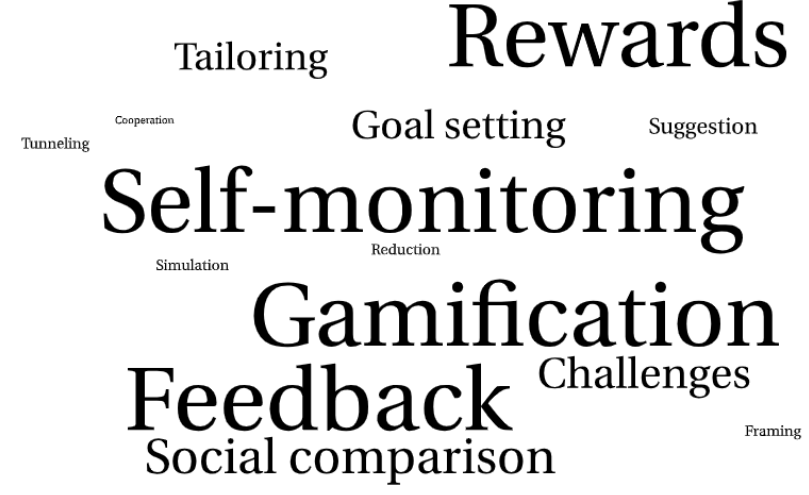
Figure 6. Word cloud with persuasion strategies.